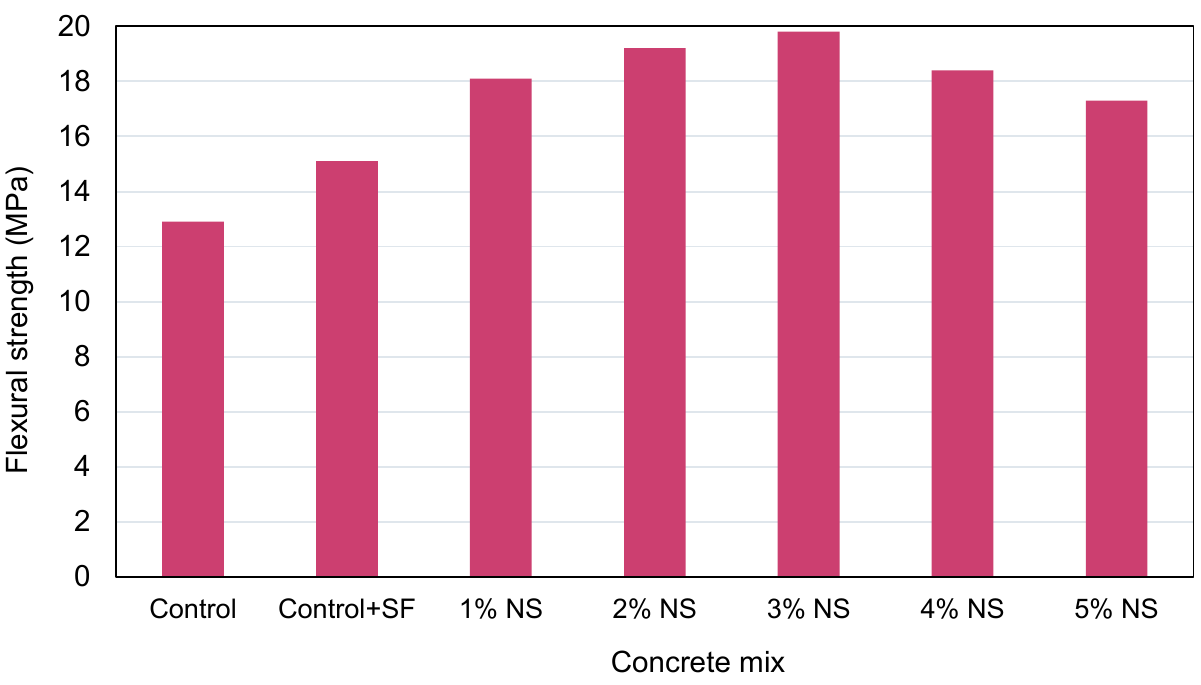
Figure 10. Influence of nano-silica dosage on flexural strength [129]. A regression analysis was also performed for the FS of NS-modified concrete. For this analysis, a total of 99 data samples were collected from the relevant literature [113,119,131,136,141,142,151]. The correlation of NS content, w/b, and speci- men age with FS was determined by designing a regression model, as given in Equation (3). This equation may be used to calculate the FS of NS-modified concrete for different NS concentrations, w/b, and specimen ages. Figure 11a illustrates the relationship between experimental and predicted results. The resulting model had an R 2 value of 0.77, suggesting that the experimental and predicted results did not agree well. This lower precision of the FS regression model might be due to the lower number of data samples employed com- pared to the CS and STS. In addition, Figure 11b displays the variance (error) between the estimated and experimental results. The error values ranged from 0.027 to 9.84 MPa, with an average of 3.69 MPa. Moreover, the error was less than 1 MPa for about 13 of the 99 data samples, between 1 and 3 MPa for 31 samples, between 3 and 5 MPa for nearly 27 samples, and greater than 5 MPa for 28 samples. These error distributions also revealed that the FS prediction regression for NS-modified concrete functioned less accurately. Hence, further studies are required to increase the number of data samples to develop accurate prediction models for the FS estimation of NS-modified